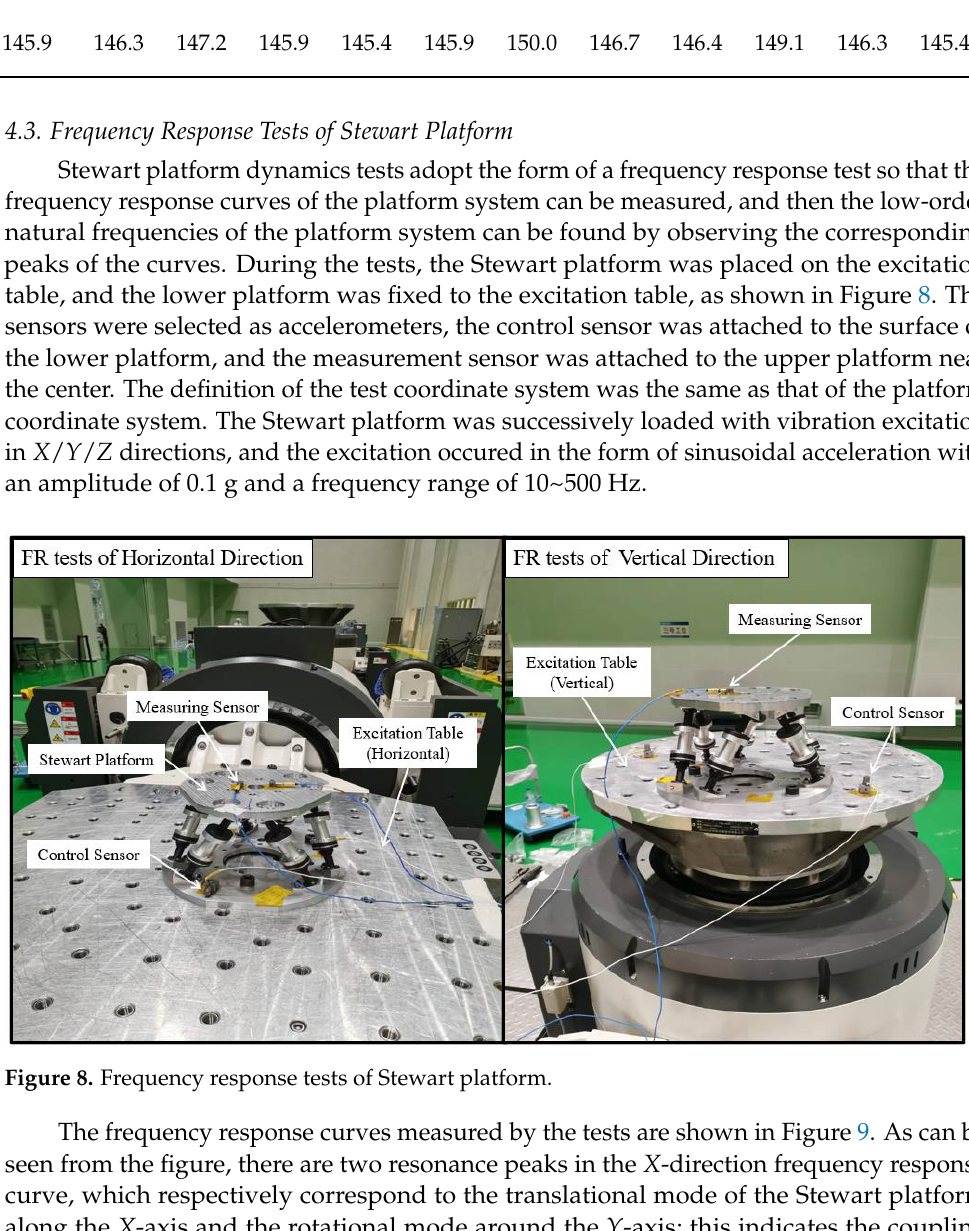
Table 3. Stiffness values of flexible components obtained from the tests.